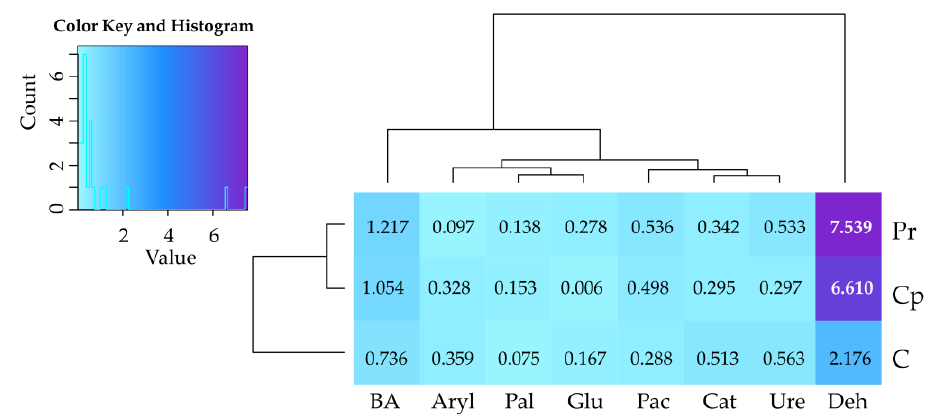
Figure 2. Index of the influence of Zea mays (IF Zm ) on the activity of soil enzymes. Deh —